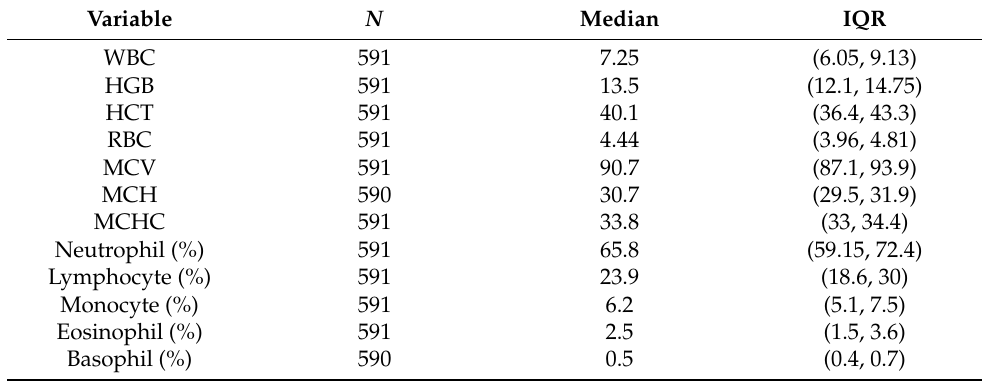
Table 2. Summary of host